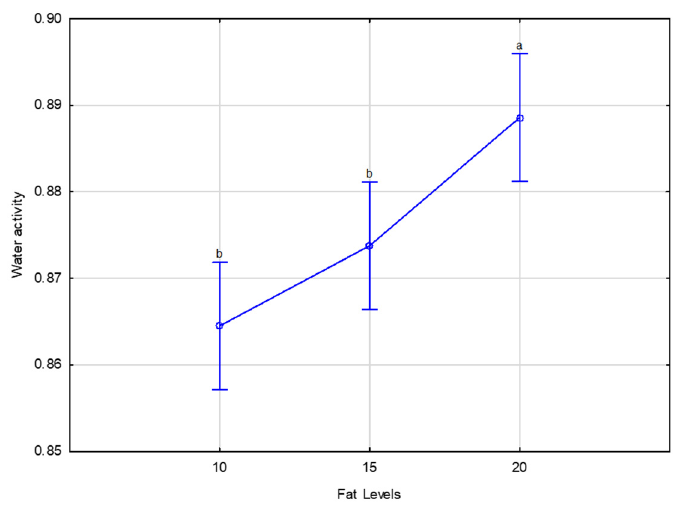
Figure 1. Water activity of zebra droëwors made with different sheep fat levels (means of day 2– day 92). ab Means with different superscripts differ ( p ≤